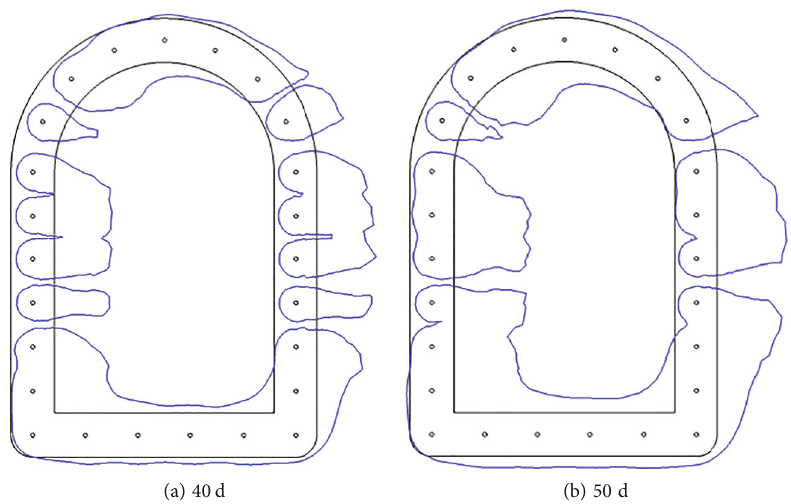
Figure 5: Frozen wall edges at di ff erent freezing duration. Table 4: Rang of values for freezing pipe layout parameters.